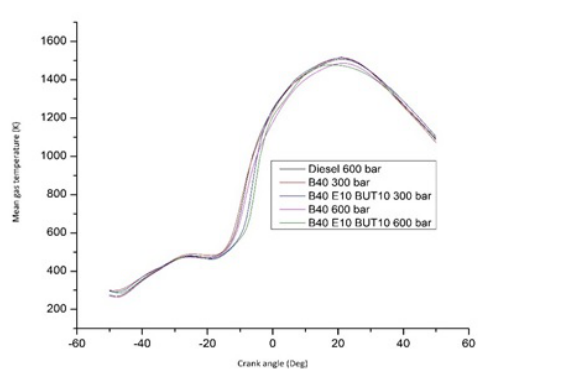
Fig. 9. Mean gas temperature with Crank